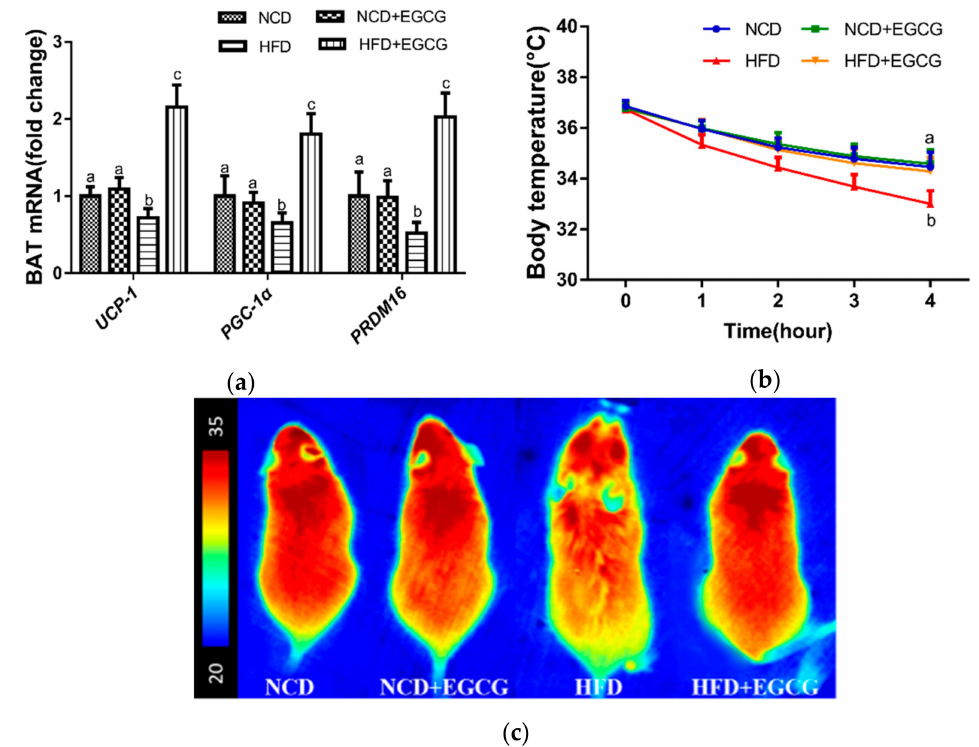
Figure 2. Effect of EGCG on thermogenesis and representative gene expression of BAT. ( a ) mRNA expressions of thermogenic-related gene in BAT; ( b ) Change of body temperature during cold exposure; ( c ) Infrared thermal images of mice after 4-hour cold exposure. Data are the means ± SD of three independent experiments performed in triplicate ( n = 3). Mean values with different letters (a, b and c) are significantly different ( p <